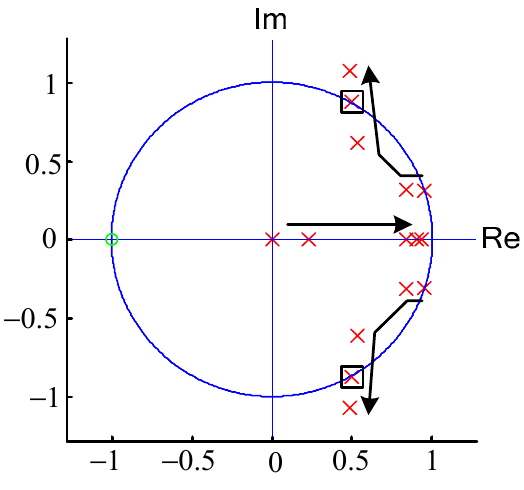
Figure 6. Diagram of poles and zeros.